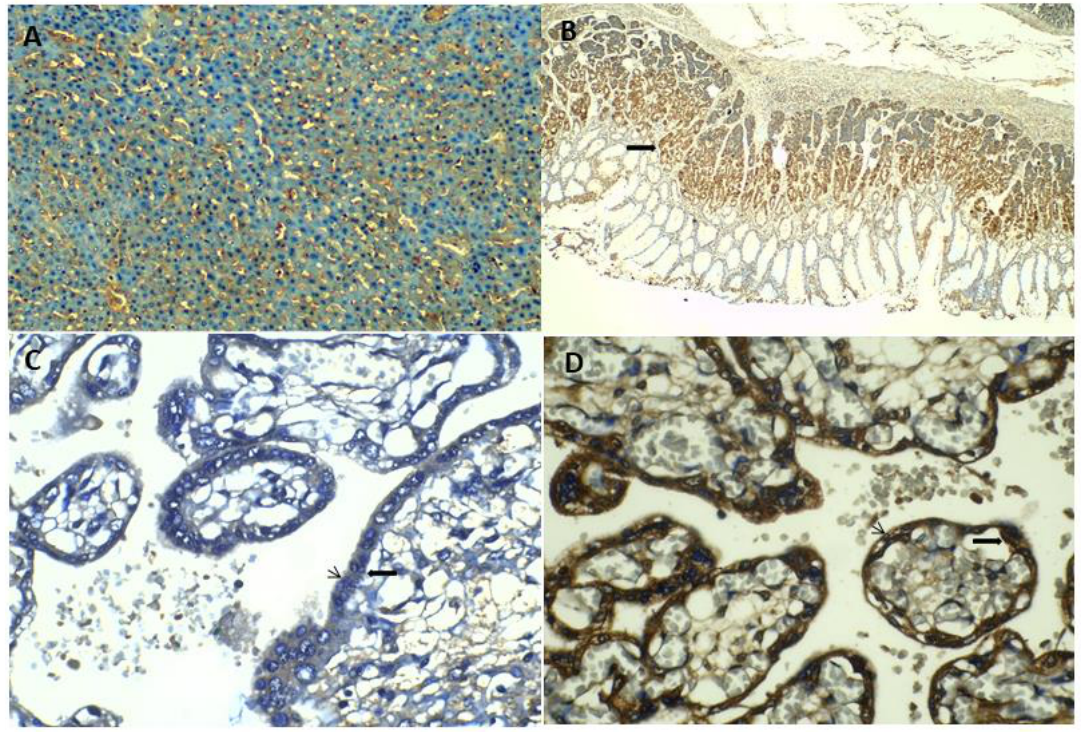
Figure 2. Immunolocalization of LEAP-2 and Ghrelin protein in human tissues. ( A ). LEAP-2 protein is immunolocated in liver tissue (10 × ). ( B ). Ghrelin protein is immunolocated in human gastric mucosa (filled arrow in ( B ) (4 × ). ( C , D ) show immunostaining of LEAP-2 ( C ) and Ghrelin ( D ), respectively in cytotrophoblasts (filled arrow) (40 × ) and syncytiotrophoblasts (arrows) (40 × ) sections of human term placentas.